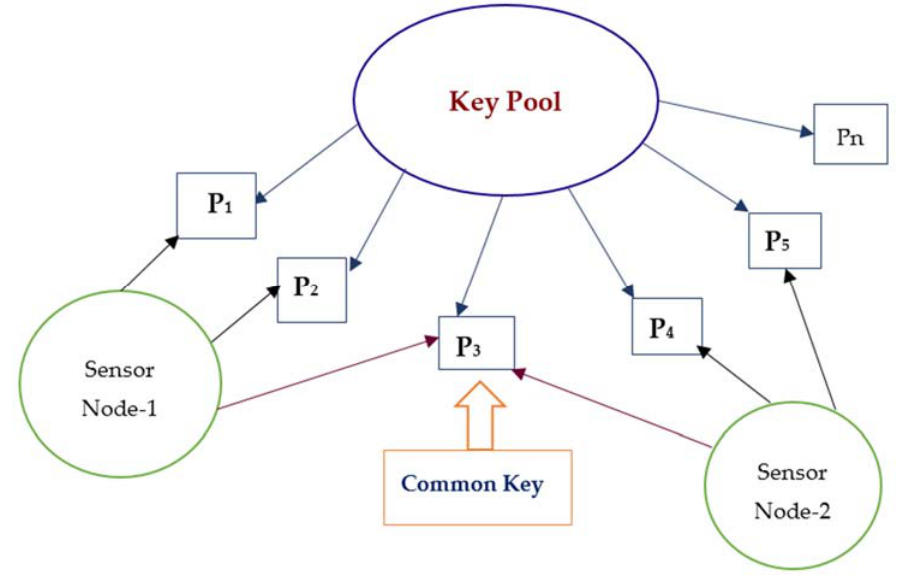
Figure 7. Eschenauer–Gligor Random Key Predistribution Scheme.